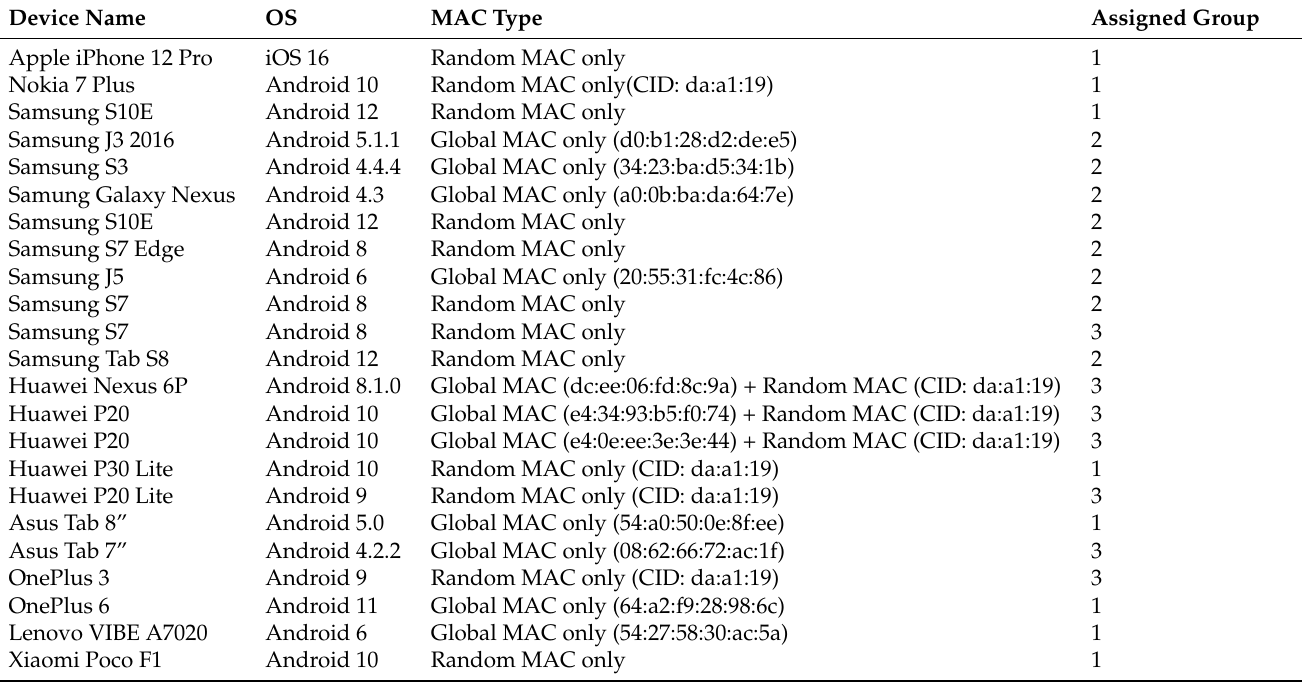
Table 2. Summary of devices used for the acquisition of